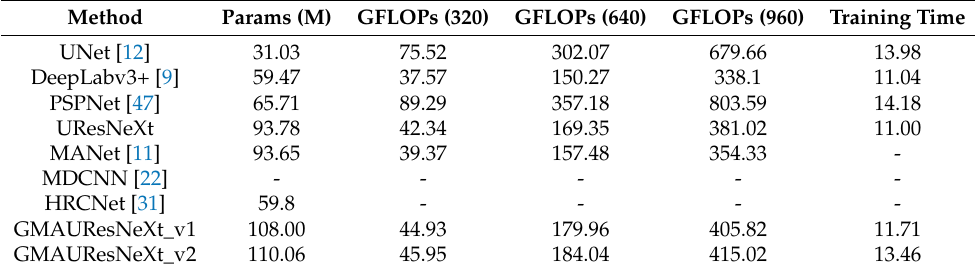
Table 3. The comparison of trainable parameters, computational complexity, and training time (hours) on the Potsdam dataset. ‘M’ represents million, ‘GFLOPs’ represents giga floating-point operations. GFLOPs(size) means the shape of the input is 3 × size × size when counting the